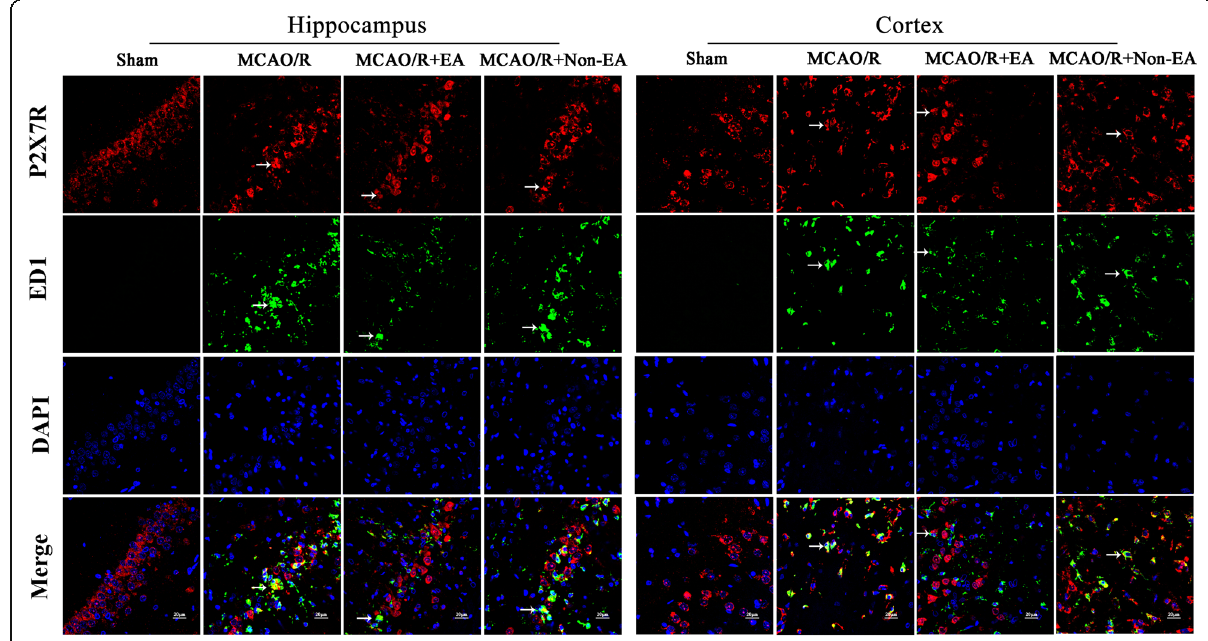
Fig. 6 Effects of EA on P2X7R and ED1 co-expression after MCAO/R injury. The co-expression of P2X7R and ED1 was examined in the hippocampal CA1 and sensorimotor cortex of each groups at Day 7 after EA. P2X7R-positive cells are green. ED1-positive cells are red. P2X7R and ED1 double-positive cells are yellow. The arrows indicate the co-expression of P2X7R and ED1. Nuclei counterstained with DAPI (blue). Scale bar 20 μ